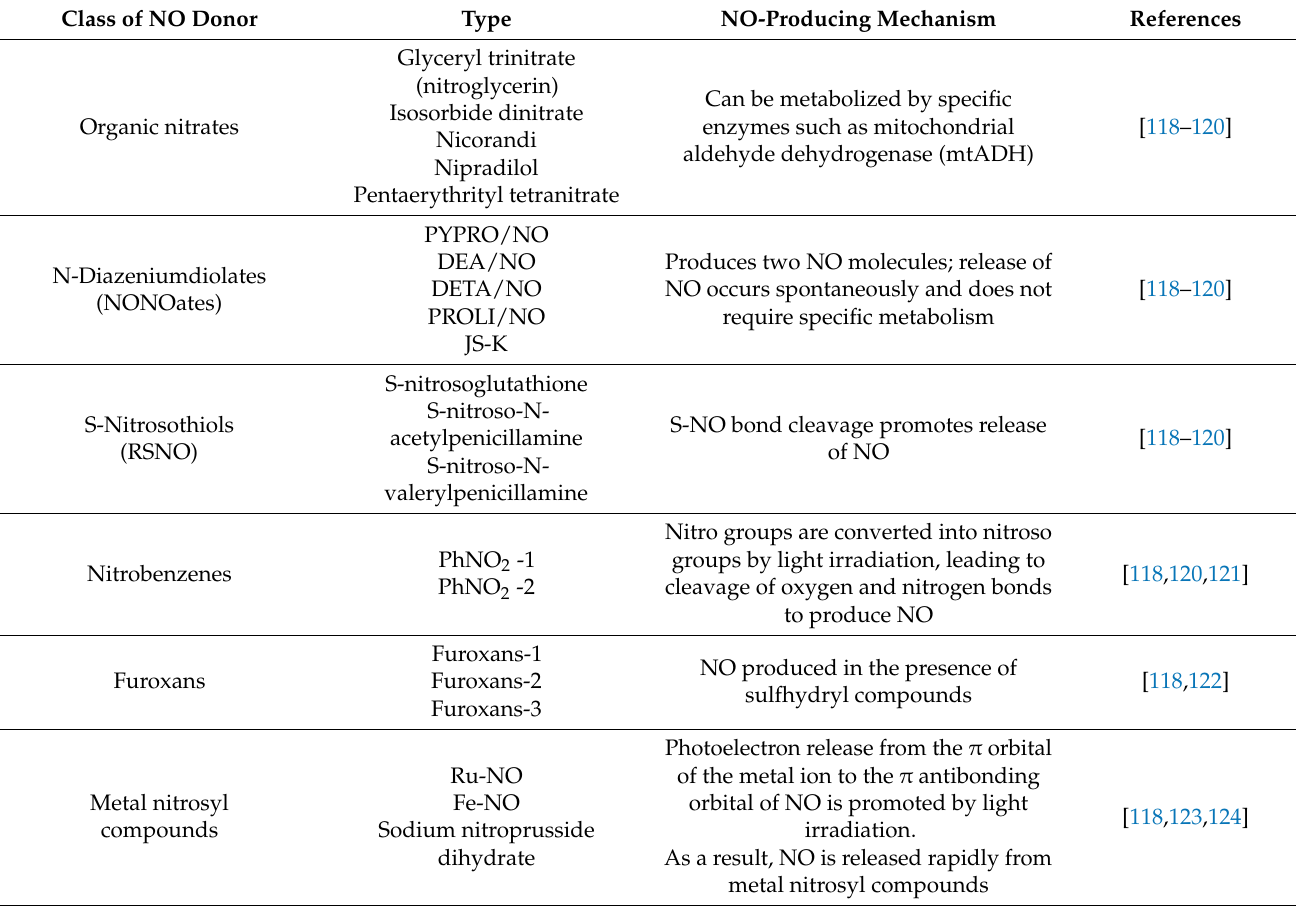
Table 4. Classes of NO donors and NO-producing